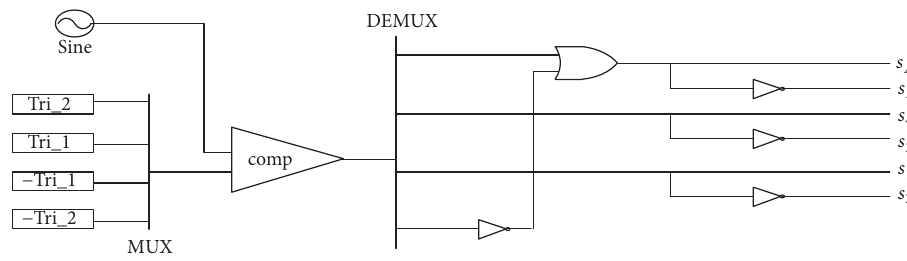
Figure 7: Control Logic circuit for driving the active